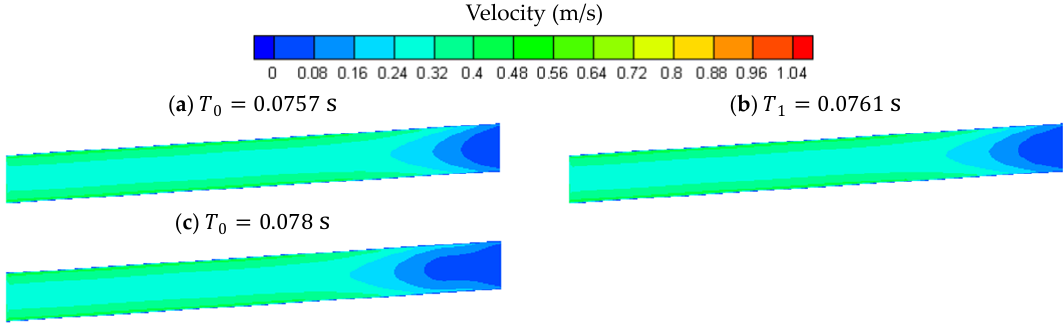
Figure 31. Pressure field evolution on the axis plane of the pipeline in the cavity growth stage.